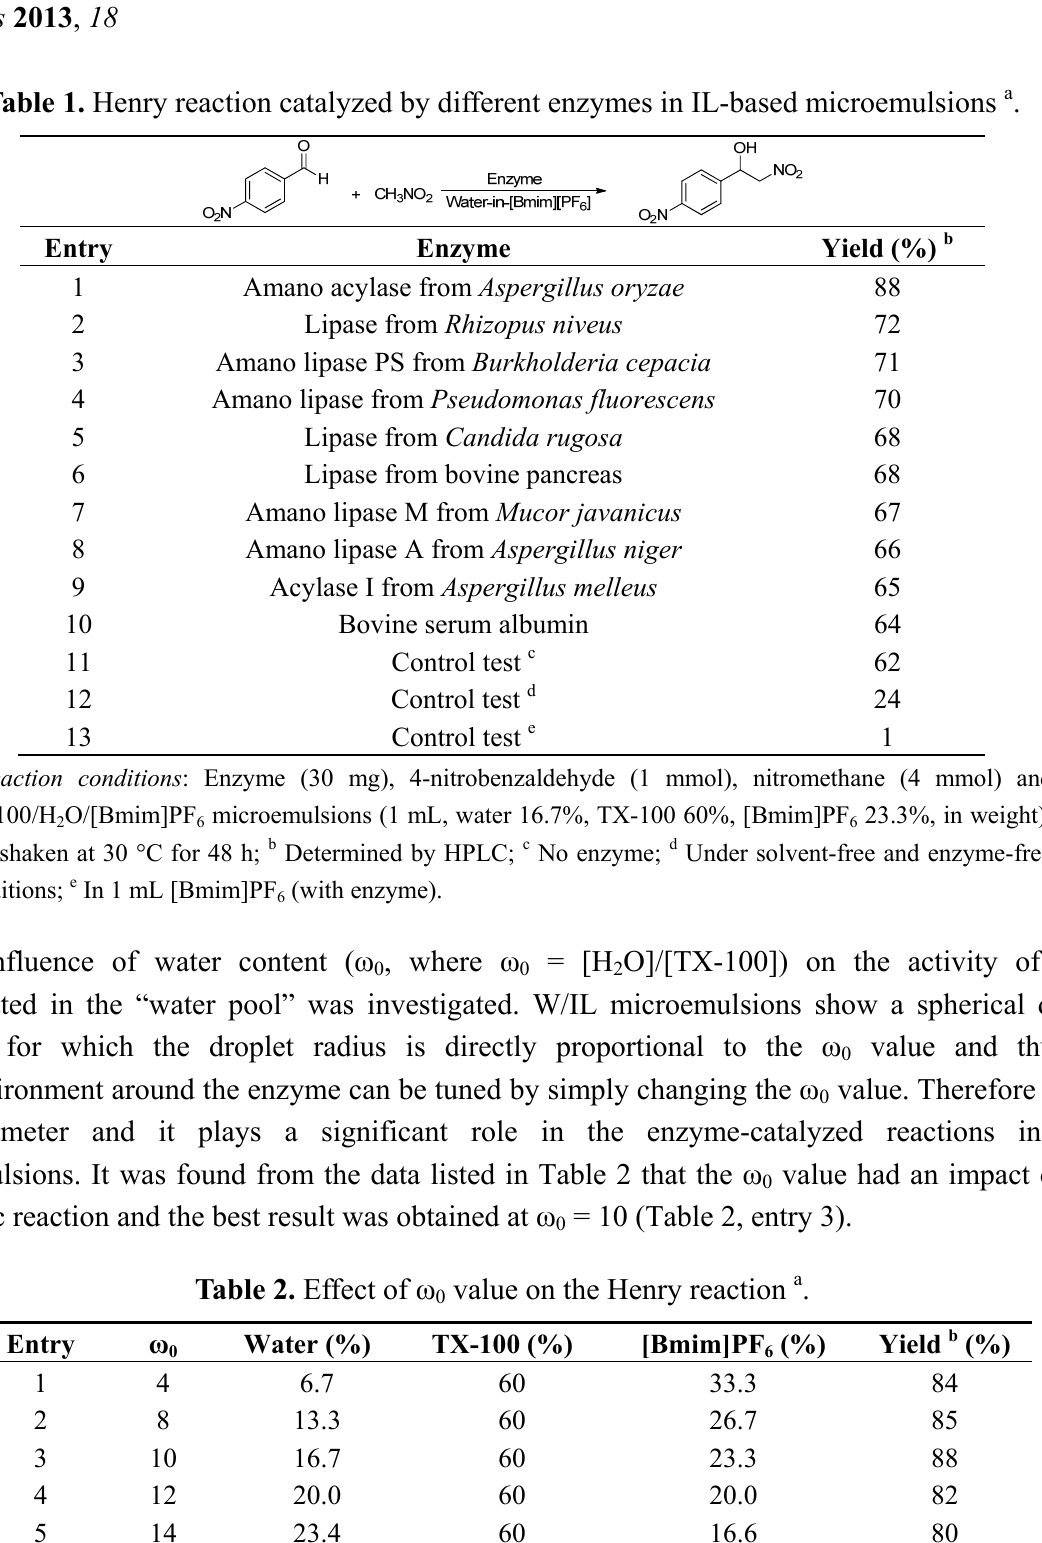
Table 1. Henry reaction catalyzed by different enzymes in IL-based microemulsions a .